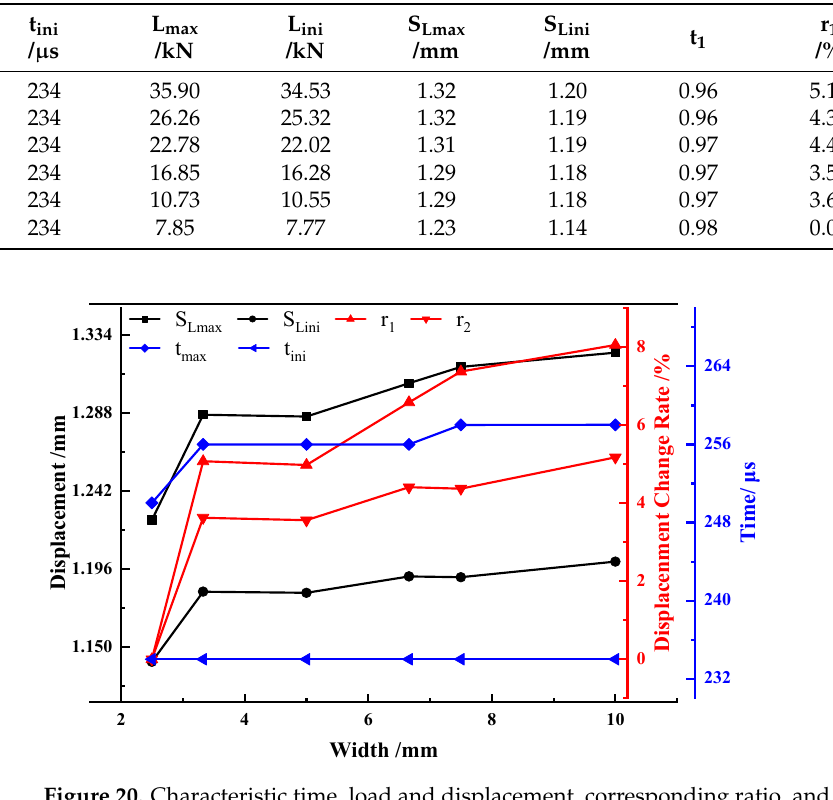
Table 7. Characteristic time, load and displacement, corresponding ratio and change rate.